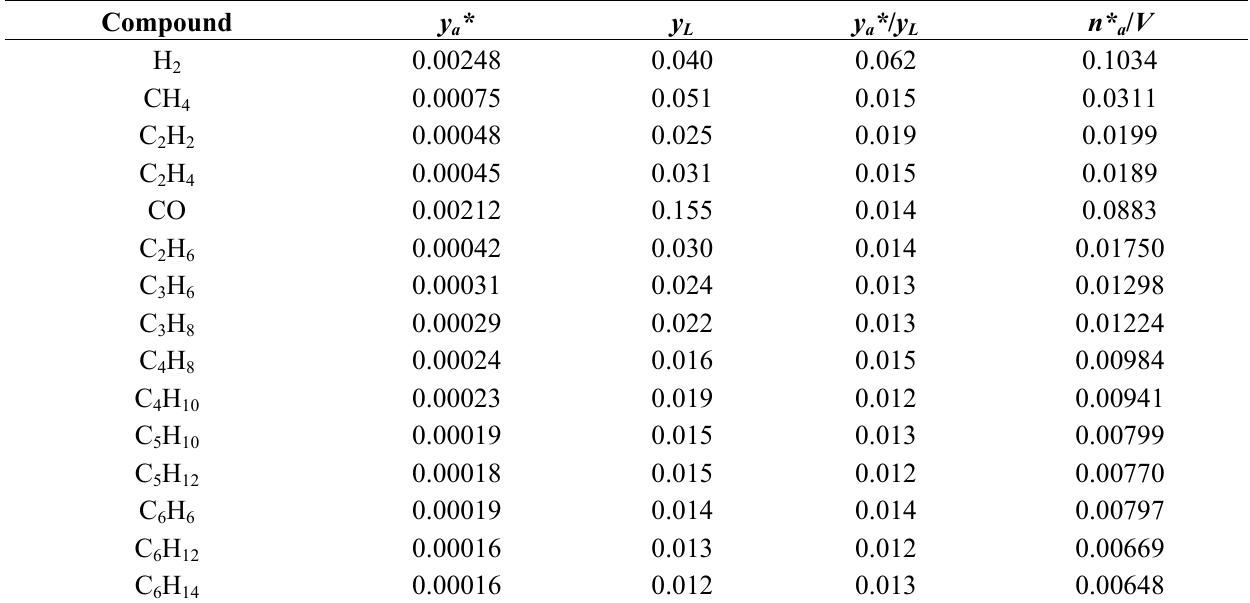
Table 2. Maximum allowed build-up and mean molar concentration calculated for different positively/neutral buoyant gases and dense gases under the overpressure constraint and corresponding average molar concentration in the